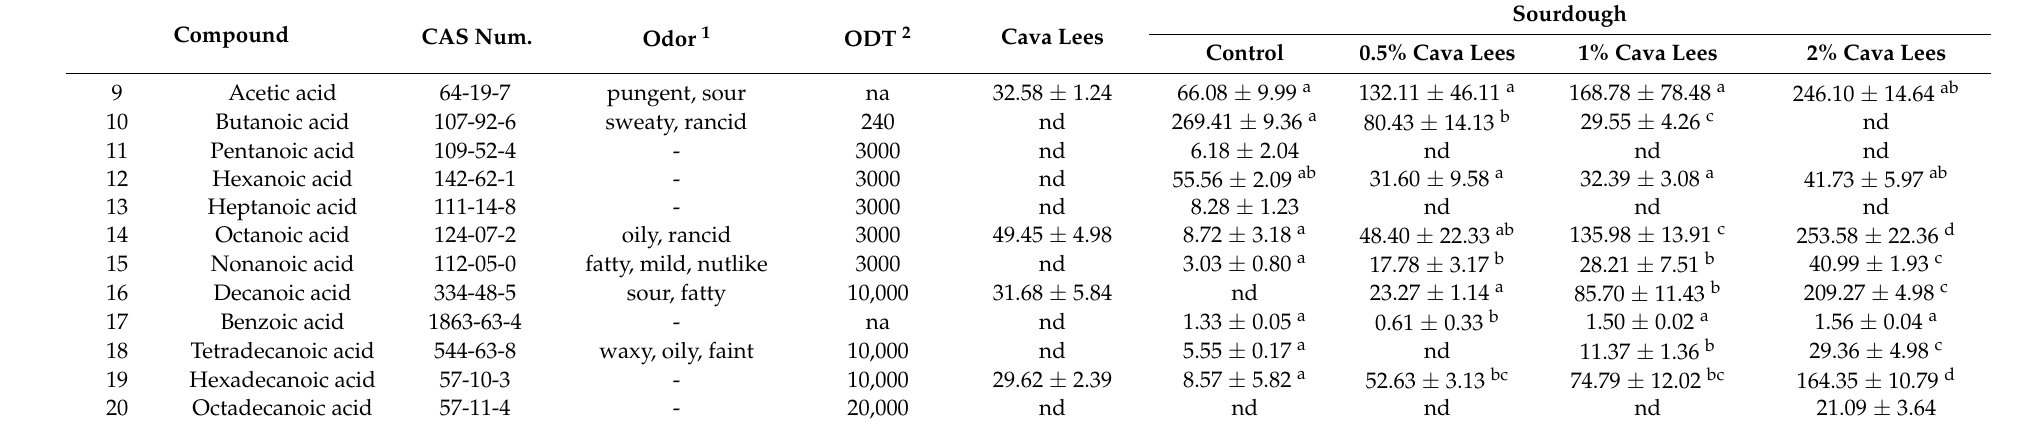
Table 3. Concentration (mg/kg) of main acids obtained with the optimized extraction parameters in Cava lees and sourdough. Compound